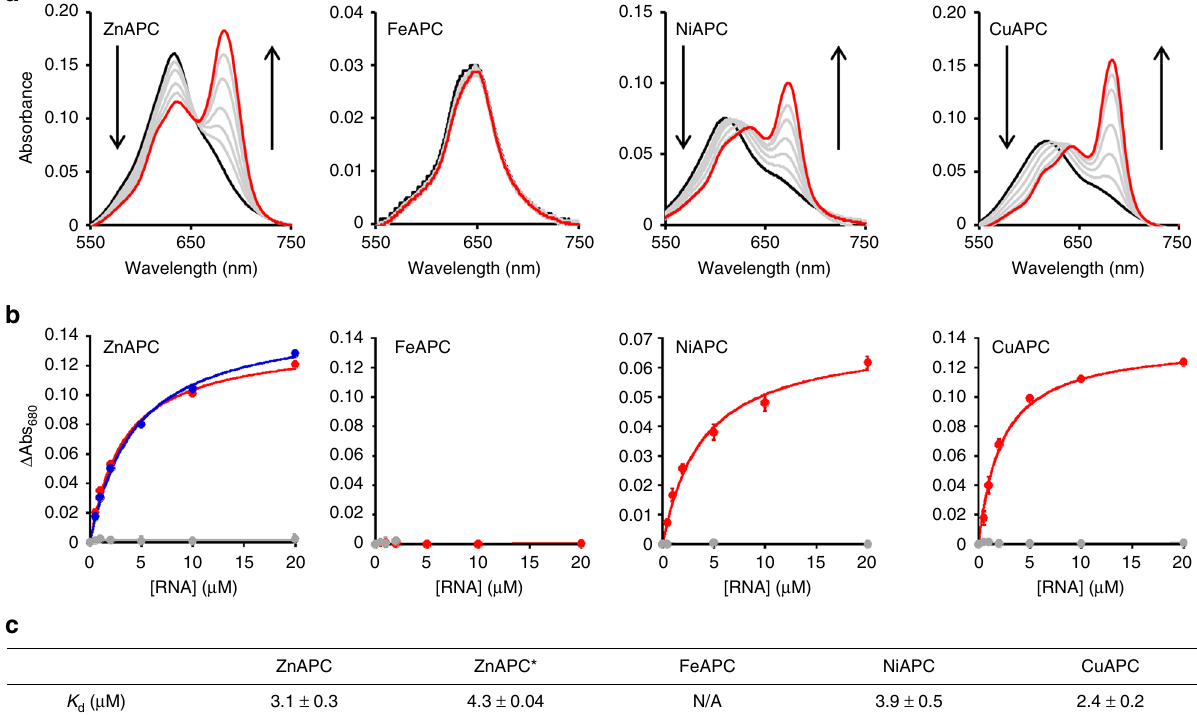
Fig. 1 ZnAPC, NiAPC and CuAPC bind to the NRAS RNA G-quadruplex. a VIS absorbance spectra of 2 μ M ZnAPC, FeAPC, NiAPC or CuAPC with 0, 0.5, 1, 2, 5, 10 or 20 μ M NRAS RNA at 25 °C. The spectra with 0 and 20 μ M NRAS RNA are highlighted in black and red, respectively. b Plots of Δ Absorbance at 680 nm ( = absorbance with NRAS RNA minus absorbance without NRAS RNA) of ZnAPC, FeAPC, NiAPC or CuAPC vs. the concentration of NRAS RNA (red) or dsRNA (grey). The plots of Δ Absorbance in the presence of 100 μ M dsRNA are also given in the ZnAPC spectrum (blue). Error bars represent mean ± SD; n = 3. c K d values of the APCs with NRAS RNA at 25